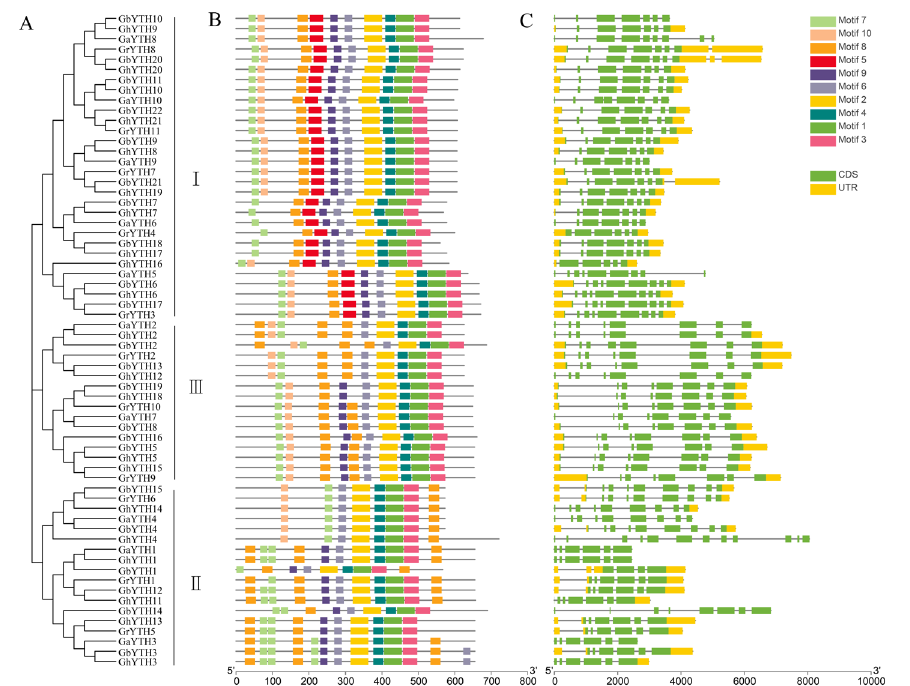
Figure 2. Phylogenetic tree, gene structure, and conserved protein motifs of YTH genes in 4 cotton species. ( A ) Phylogenetic tree of 4 cotton species. ( B ) Protein motifs in Gossypium YTHs . Each colored box indicates a specific motif. ( C ) The exon–intron structure of cotton YTH genes. The yellow boxes represent untranslated regions (UTRs), the green boxes indicate exons, and the grey lines indicate introns.